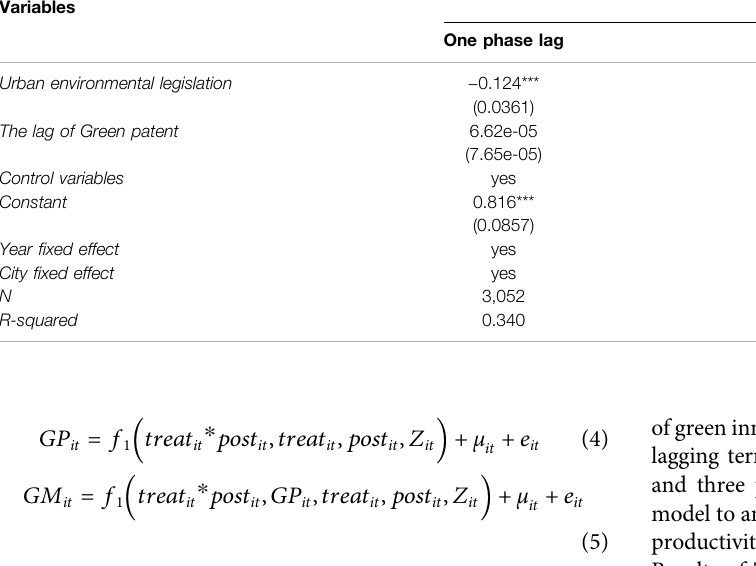
TABLE 11 | Regression results of the hypotheses.